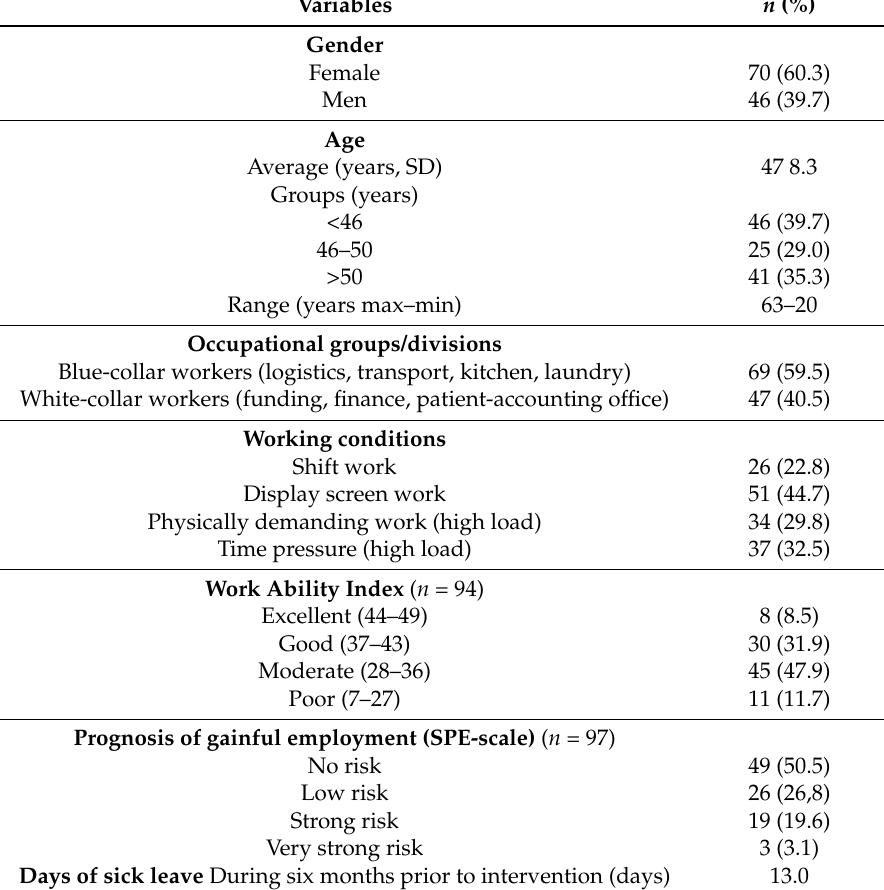
Table 1. Sample characteristics at t1, n = 116.